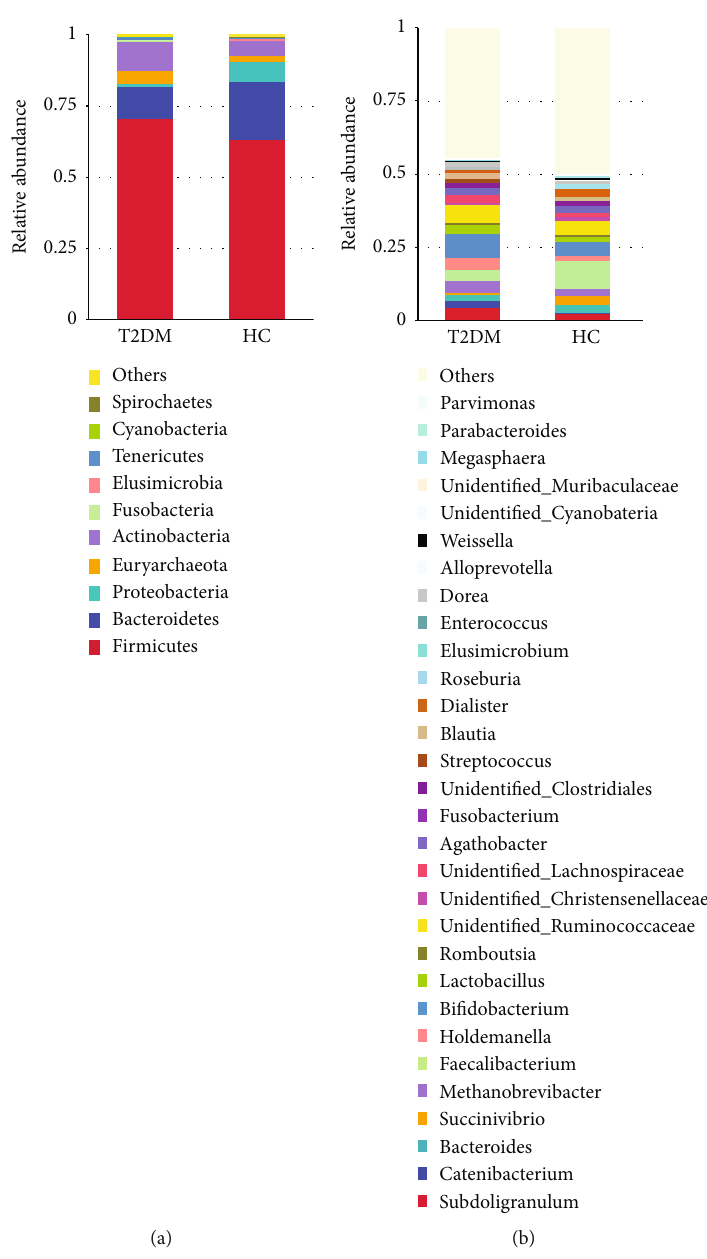
Figure 2: Comparison of gut micro fl ora between HC ( n = 24 ) and T2DM ( n = 24 ) individuals. (a) and (b) show the relative abundance of bacteria at the phylum and genus level, respectively. HC: healthy control; n : number; T2DM: type 2 diabetes